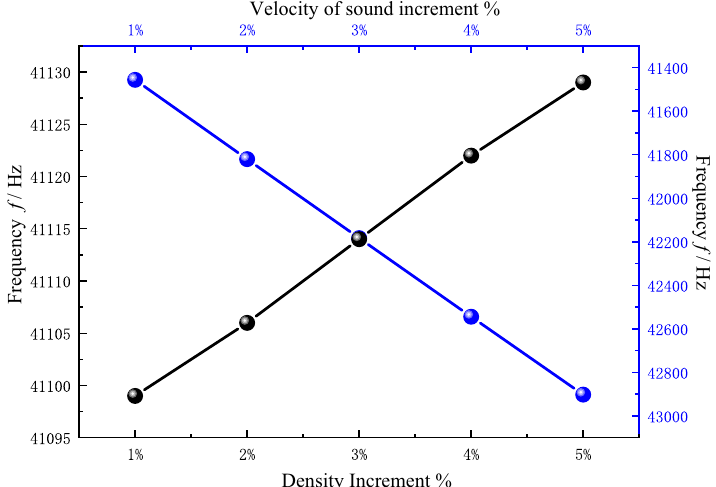
Figure 10. The relationship of each resonance frequency generated by increasing the sound speed and density by 1–5% based on water.